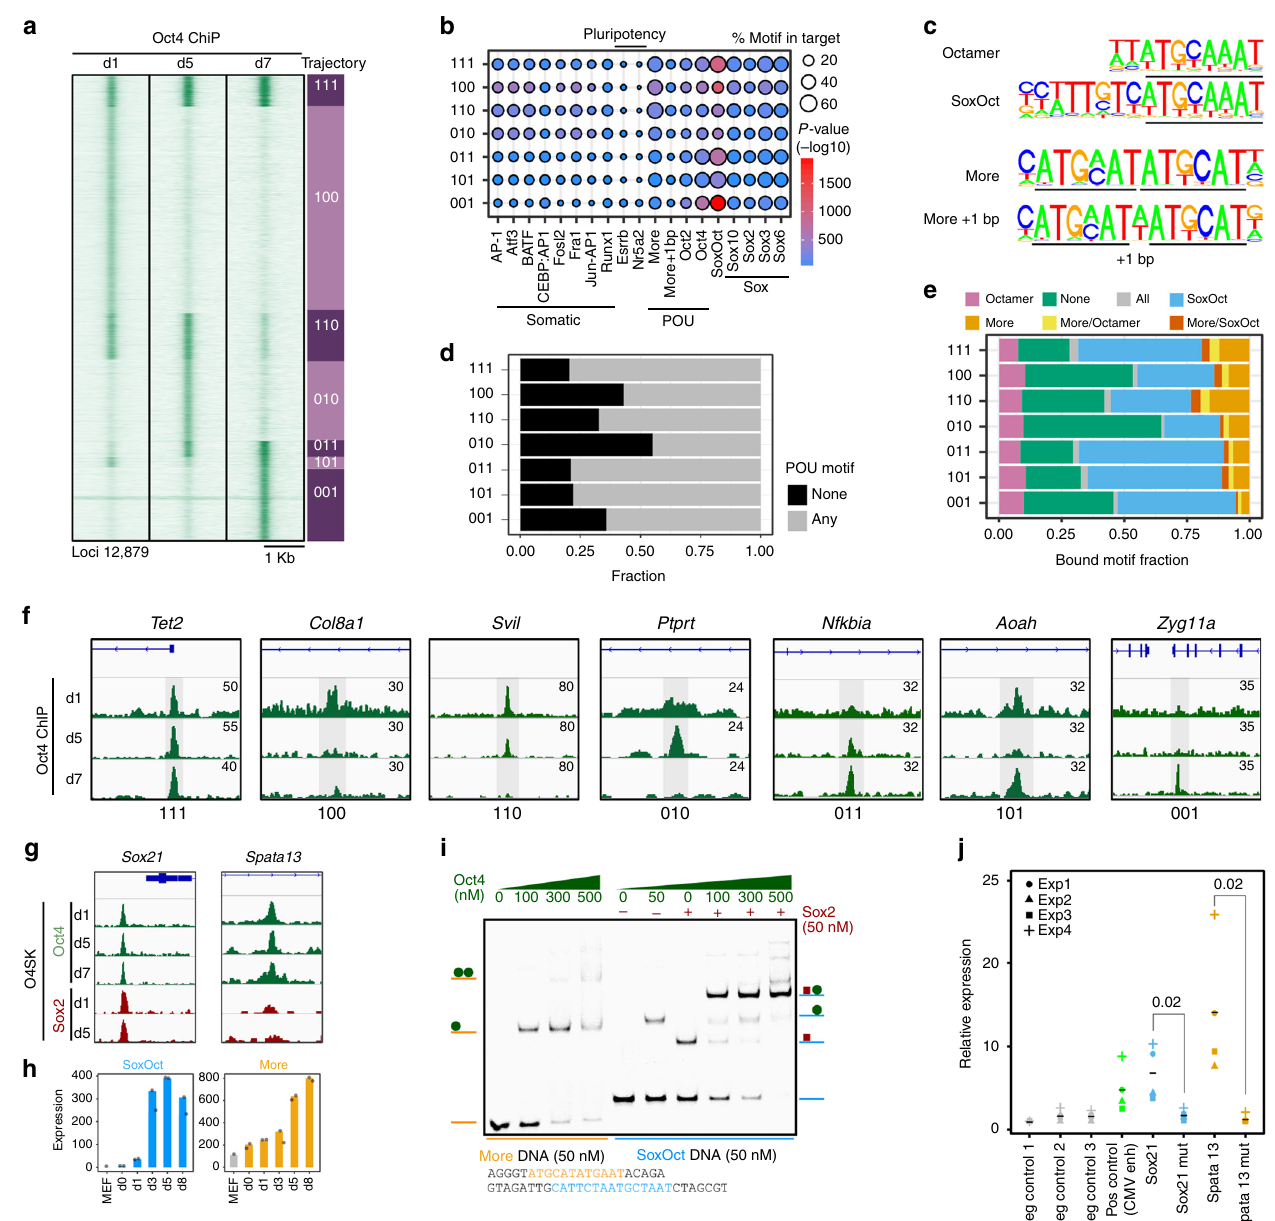
Fig. 2 Determinants for the binding trajectories of Oct4. a Heatmap of Oct4 ChIP-seq signal within 2 kb window centered at Oct4 summits. Rows are Oct4 peaks arranged in 7 binary trajectories. 1 indicates presence and 0 absence of binding; left to right digits are days 1, 5 and 7. Summits were merged if within 100 bp. Genomic locations are provided in Supplementary Data 2. b Enrichment of selected TF motifs in Oct4 occupancy trajectories. Point size represents the proportion of sequences with the motif and color gradient (blue to red) the p -value score. c Consensus binding motifs of Oct4 represented as PWMs (position weight matrices). POU binding sites are underlined. d Proportion of ChIP-seq peaks in each occupancy trajectory featuring ‘ any ’ (consensus motifs shown in c ) or ‘ none ’ of these POU motifs. e Fraction of binding locations for each occupancy trajectory containing the indicated POU motifs. ‘ All ’ refers to peaks where motif scanning concurrently detected all the POU motifs listed in ( c ) and ‘ none ’ the absence of any of these motifs. f Genome browser track of Oct4 ChIP-seq peaks (shaded gray) for selected trajectories. Genomic coordinates for the summits are listed in Supplementary Table 4. g Genome browser tracks of constitutively bound Oct4 and Sox2 ChIP-seq peaks containing either SoxOct (near Sox21 gene) or MORE (near Spata13 gene) motifs. h Gene expression (mean tag counts as bar and individual technical replicate as dots) of Sox21 and Spata13 in the Oct4 condition. i EMSAs using Oct4-POU and Sox2-HMG protein constructs and DNA probes containing SoxOct elements (near the Sox21 gene) or MORE elements (near the Spata13 gene). EMSA probes are provided in Supplementary Table 5. j STARR reporter assay 38 in ESCs with Oct4 bound regions from ( g ) near Sox21 or Spata13 . The positive and negative control sequences are shown in Supplementary Table 8. Each data point ( n = 4, biological replicates) is shown with mean as black bar; indicated p-values were calculated by Student ’ s t-test. Source data for i and j are provided as a Source Data fi